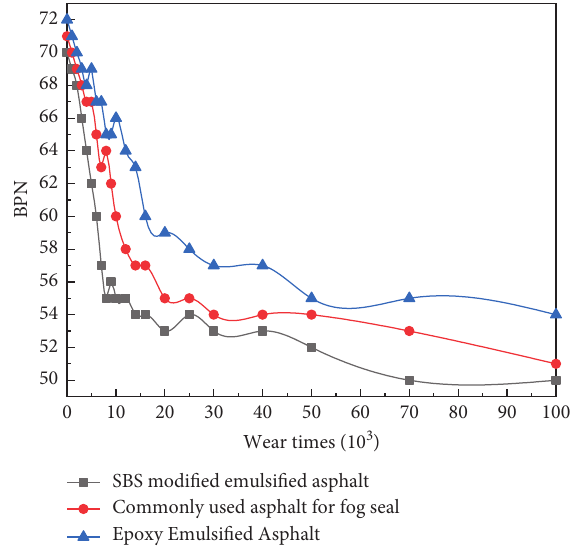
Figure 24: BPN abrasion